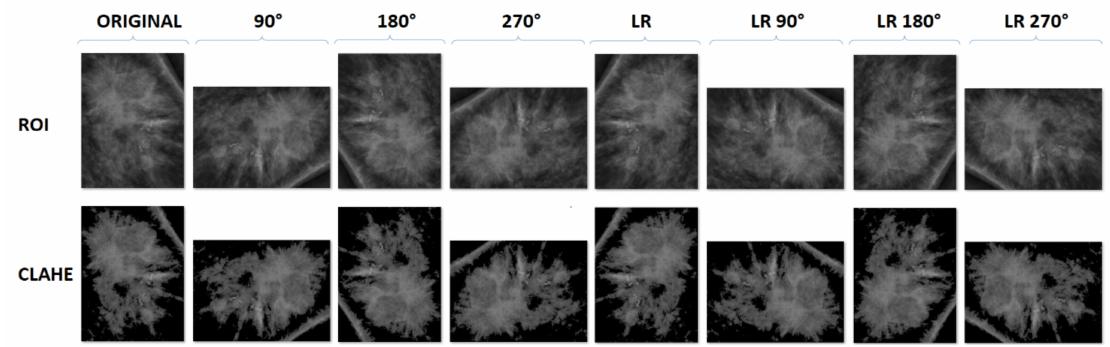
Figure 3. Augmented malign